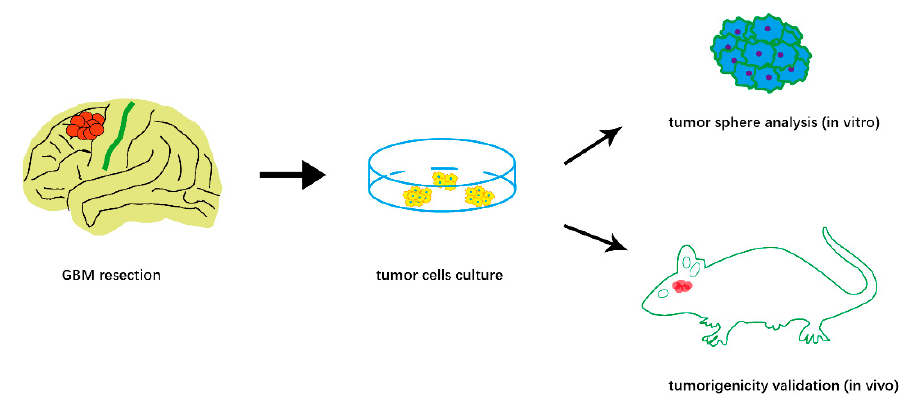
Figure 1. Schematic illustration of patient-derived xenografts (PDX) to study GBM biology.